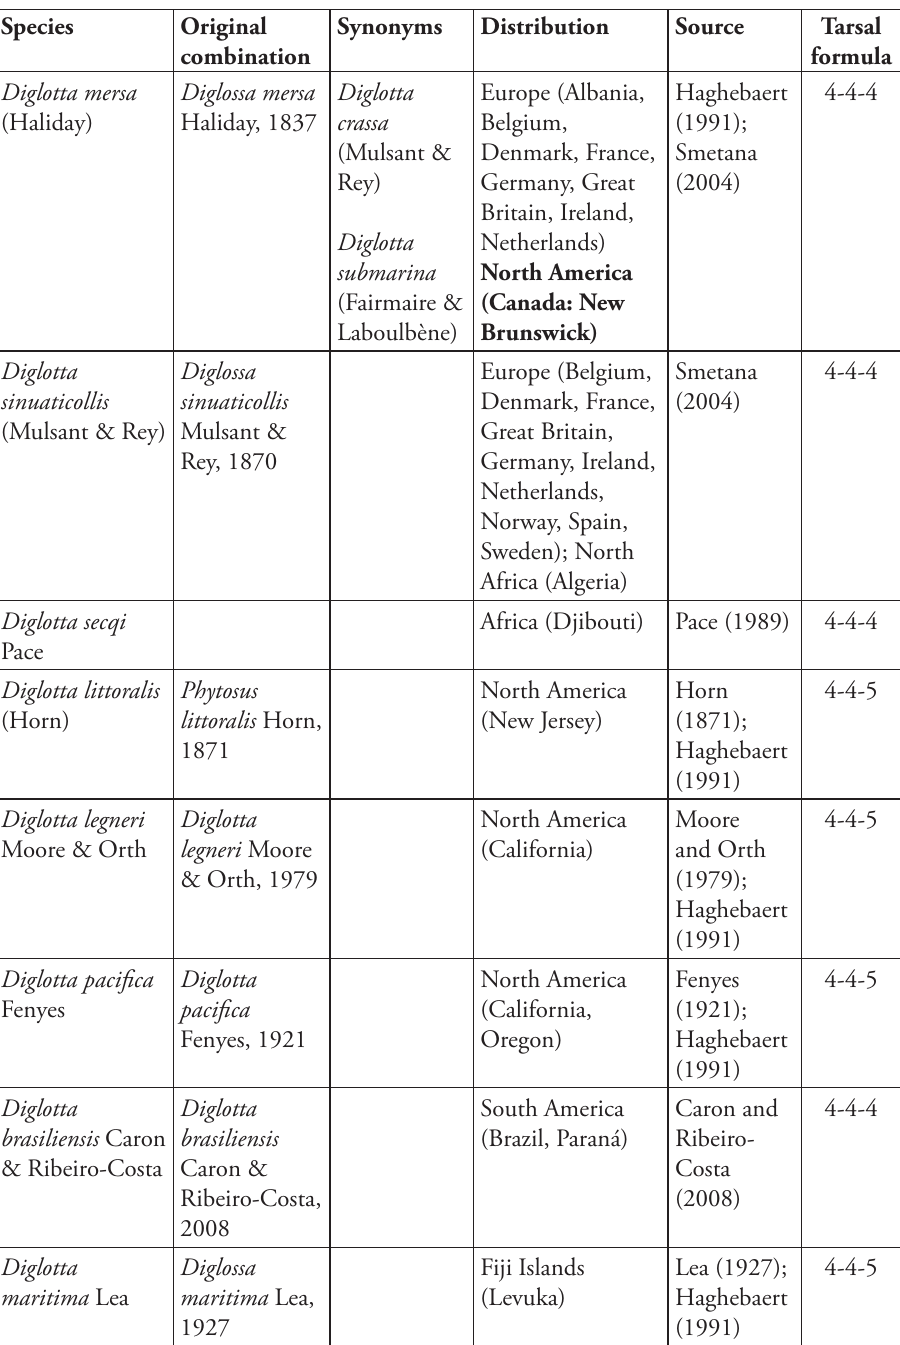
Table 1. World checklist of Diglotta species. New record is in